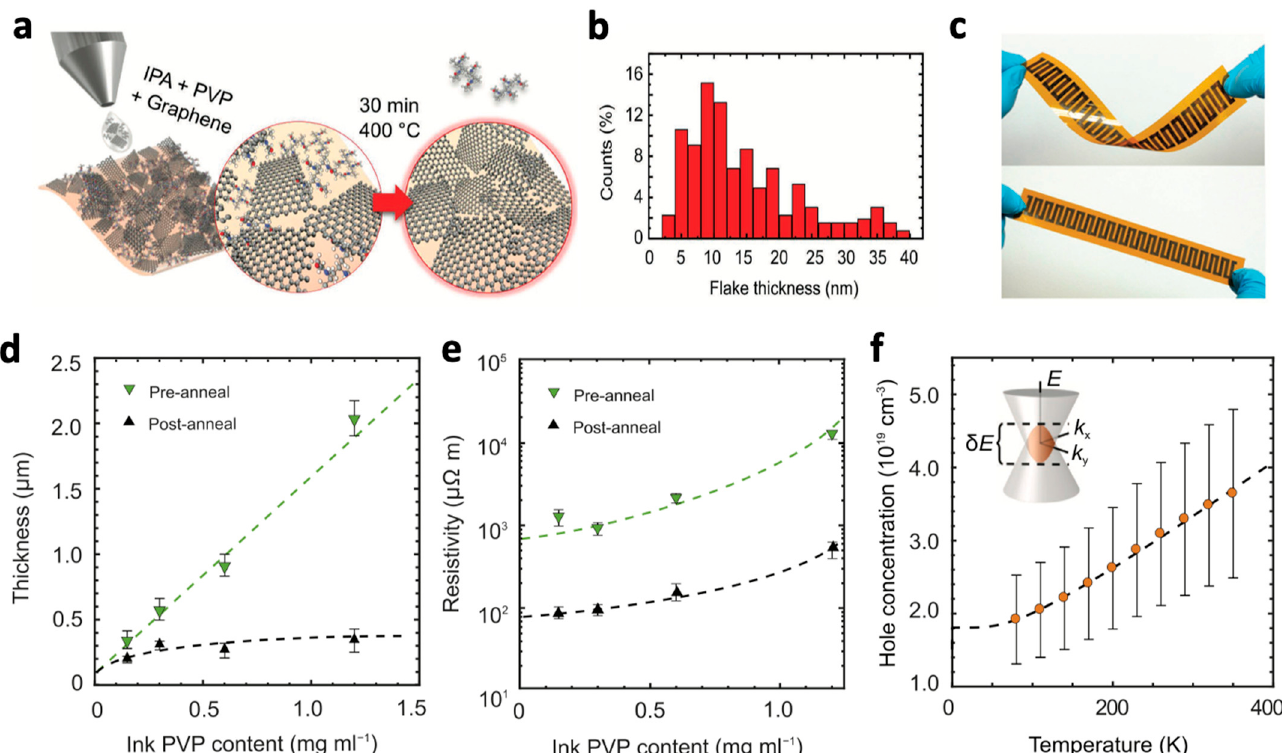
Figure 3. Deposition and characterization of the graphene thin films: ( a ) deposition and annealing scheme of the exfoliated few-layer graphene flakes suspended in an IPA/PVP solution; ( b ) AFM thickness distribution of graphene flakes after annealing. ( c ) Photographs of an inkjet-printed device consisting of 20 silver and graphene legs bent (above) and as is (below); thermoelectric and transport characterization of graphene films: ( d ) thickness, ( e ) resistivity as a function of ink PVP concentration pre- and post-annealing; ( f ) post-annealing charge concentration with band overlap energy δ E = 28.1 ± 2.3 meV as illustrated in the inset for two parabolic bands. Reprinted with permission from Ref. [44], Copyright 2018 John Wiley and Sons.